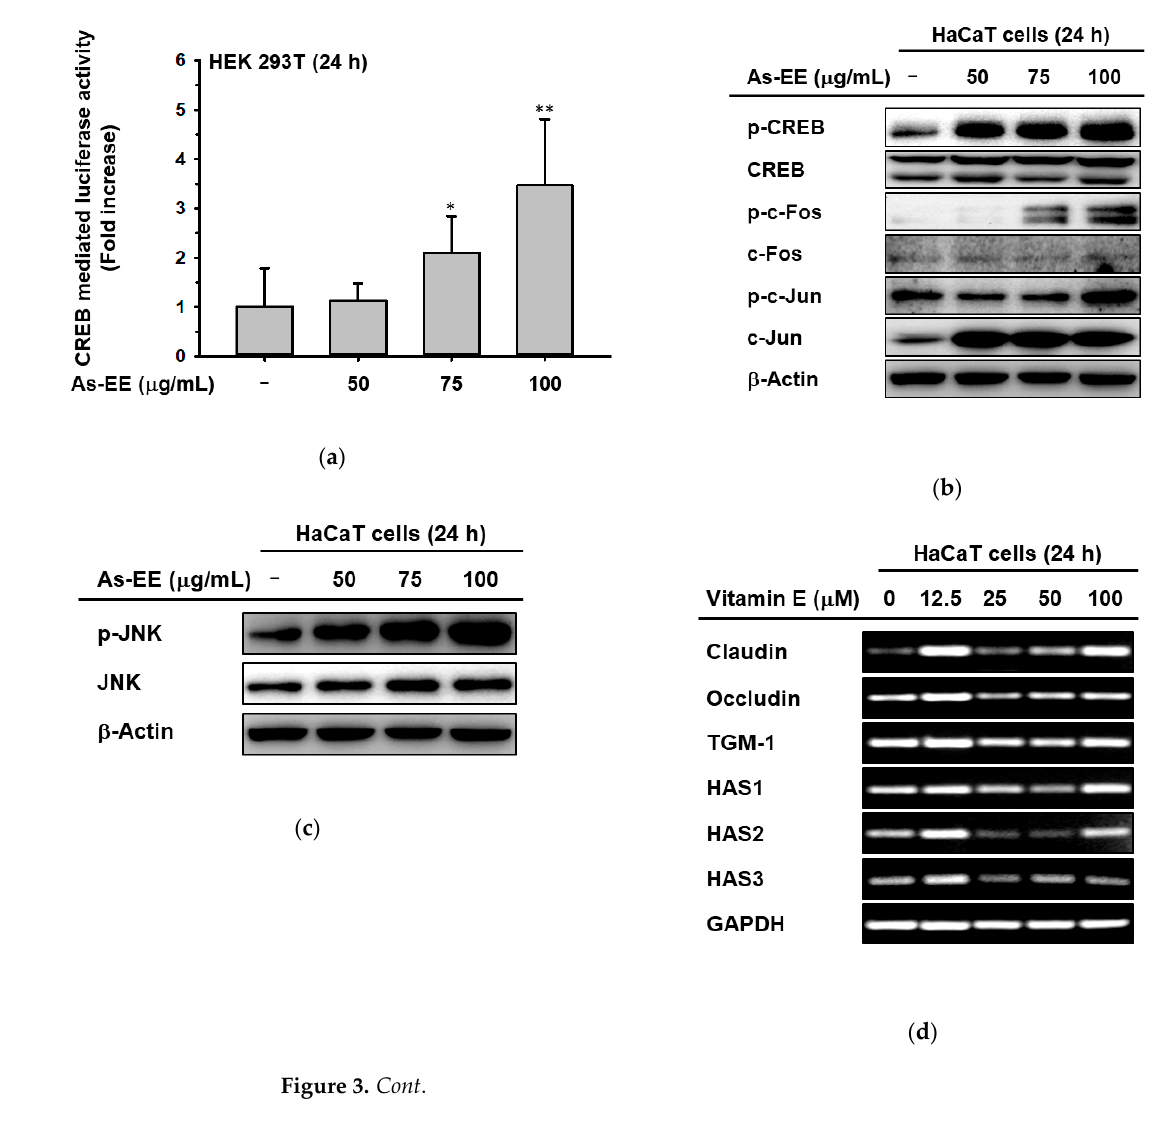
( f ) Figure 3. Effects of As-EE on MAPK-mediated AP-1 and CREB signaling pathway. ( a ) HEK293T cells transfected with CREB-Luc were incubated with As-EE for 24 h. A galactosidase construct was used as a control, and luciferase activity was measured using a luminometer; ( b , c ) HaCaT cells were incubated with As-EE for 24 h. Immunoblot analysis was used to evaluate the phosphorylation levels of c-Jun, c-Fos, p-CREB, and JNK; ( d ) RT-PCR was used to evaluate the expression levels of skin-barrier-related and hydration factors in HaCaT cells after treatment with vitamin E in a dose- dependent manner from 0 to 100 µM for 24 h; ( e ) Luciferase assay; ( f ) Phosphorylation level of JNK was measured with immunoblotting in HaCaT cells treated with vitamin E for 24 h. * p < 0.05 and ** p < 0.01 compared with the normal groups. 2.4. Moisturizing and Anti-Apoptotic Effect of As-EE in UVB-Irradiated Human Keratinocytes Previous reports suggest that the ability of UVB radiation to impair the skin immune system has been widely documented, and UVB-induced damage is a key factor in the development of sun-induced skin cancer [55,56]. To explore the potential ability of As-EE in protecting keratinocytes against UVB irradiation, the morphological changes in As-EE- treated HaCaT cells stimulated with UVB were detected using phase-contrast microscopy. Expectedly, the number of floating dead cells was reduced in the As-EE-pre-treated group